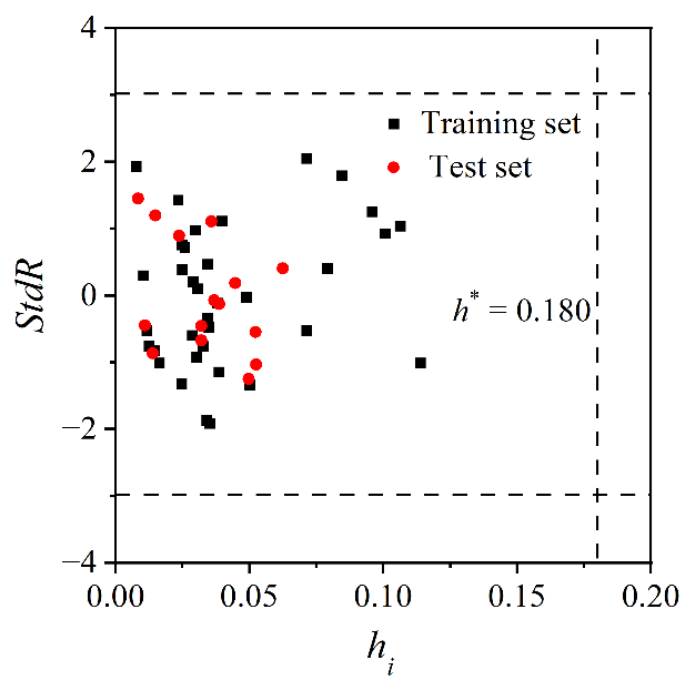
Figure 6. Williams diagram of MLR model.